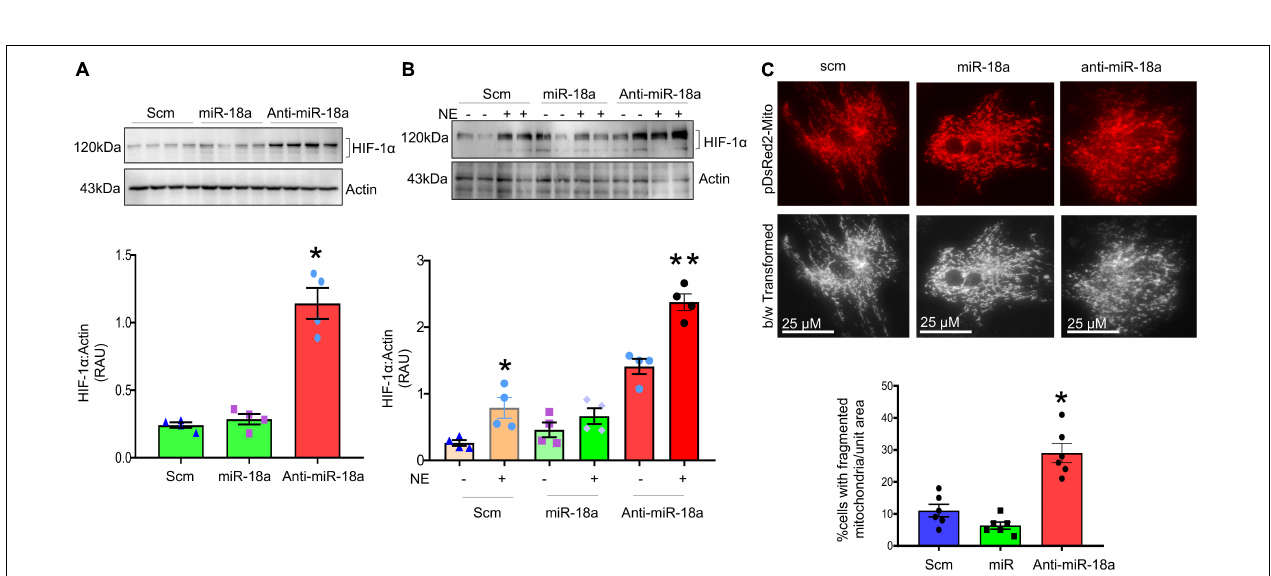
Frontiers in Physiology |